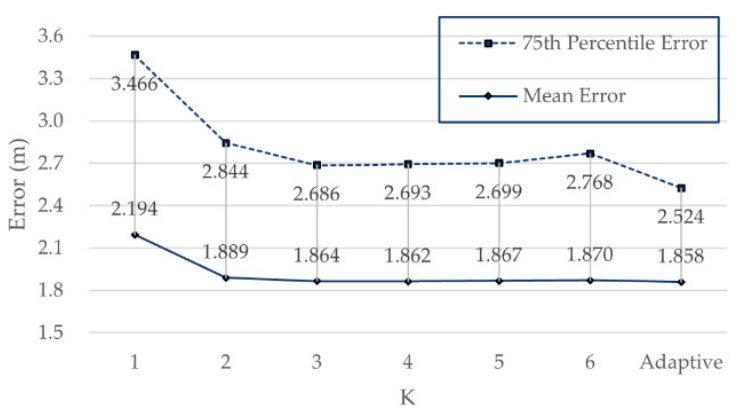
Figure 10. Positioning errors of different K and adaptive K based on Q-WKNN on Zenodo.